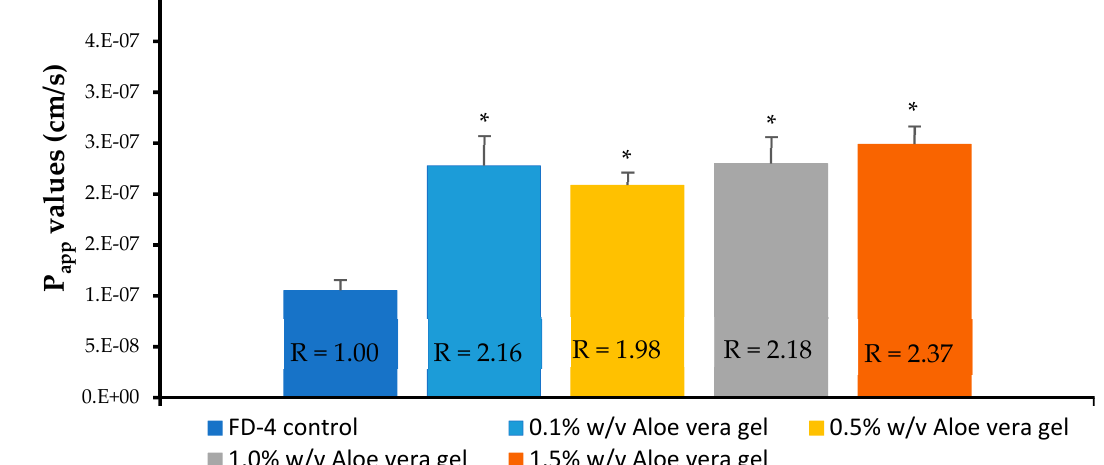
10 of 17 Figure 4. Percentage transport of the Fluorescein isothiocyanate (FITC)-dextran (FD) (FD-4 with MW of 4 kDa) plotted as a function of time, across the Caco-2 cell monolayers, in the absence (FD-4 control) and presence of the Aloe vera gel solutions, with different concentrations ( n = 3; error bars represent SD) From Figure 4, a clear increase in the percentage transport of FD-4, in relation to the negative